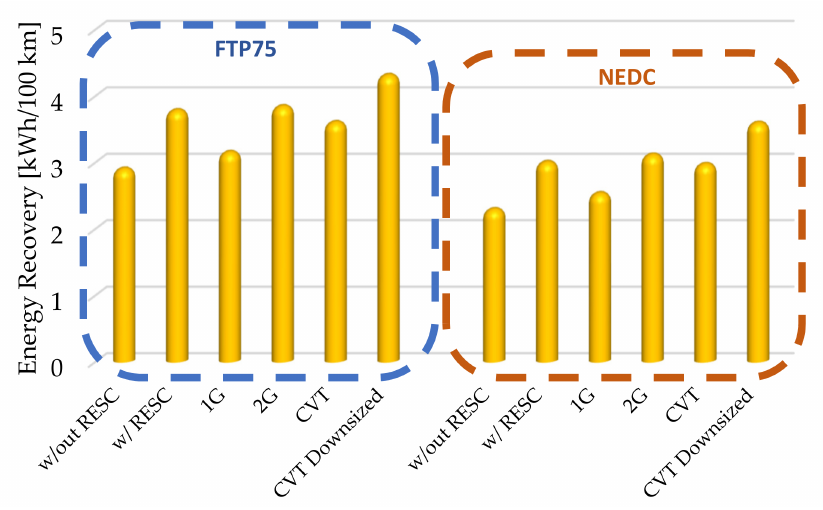
Figure 15. Energy recovery rates per 100 km for FTP75 and